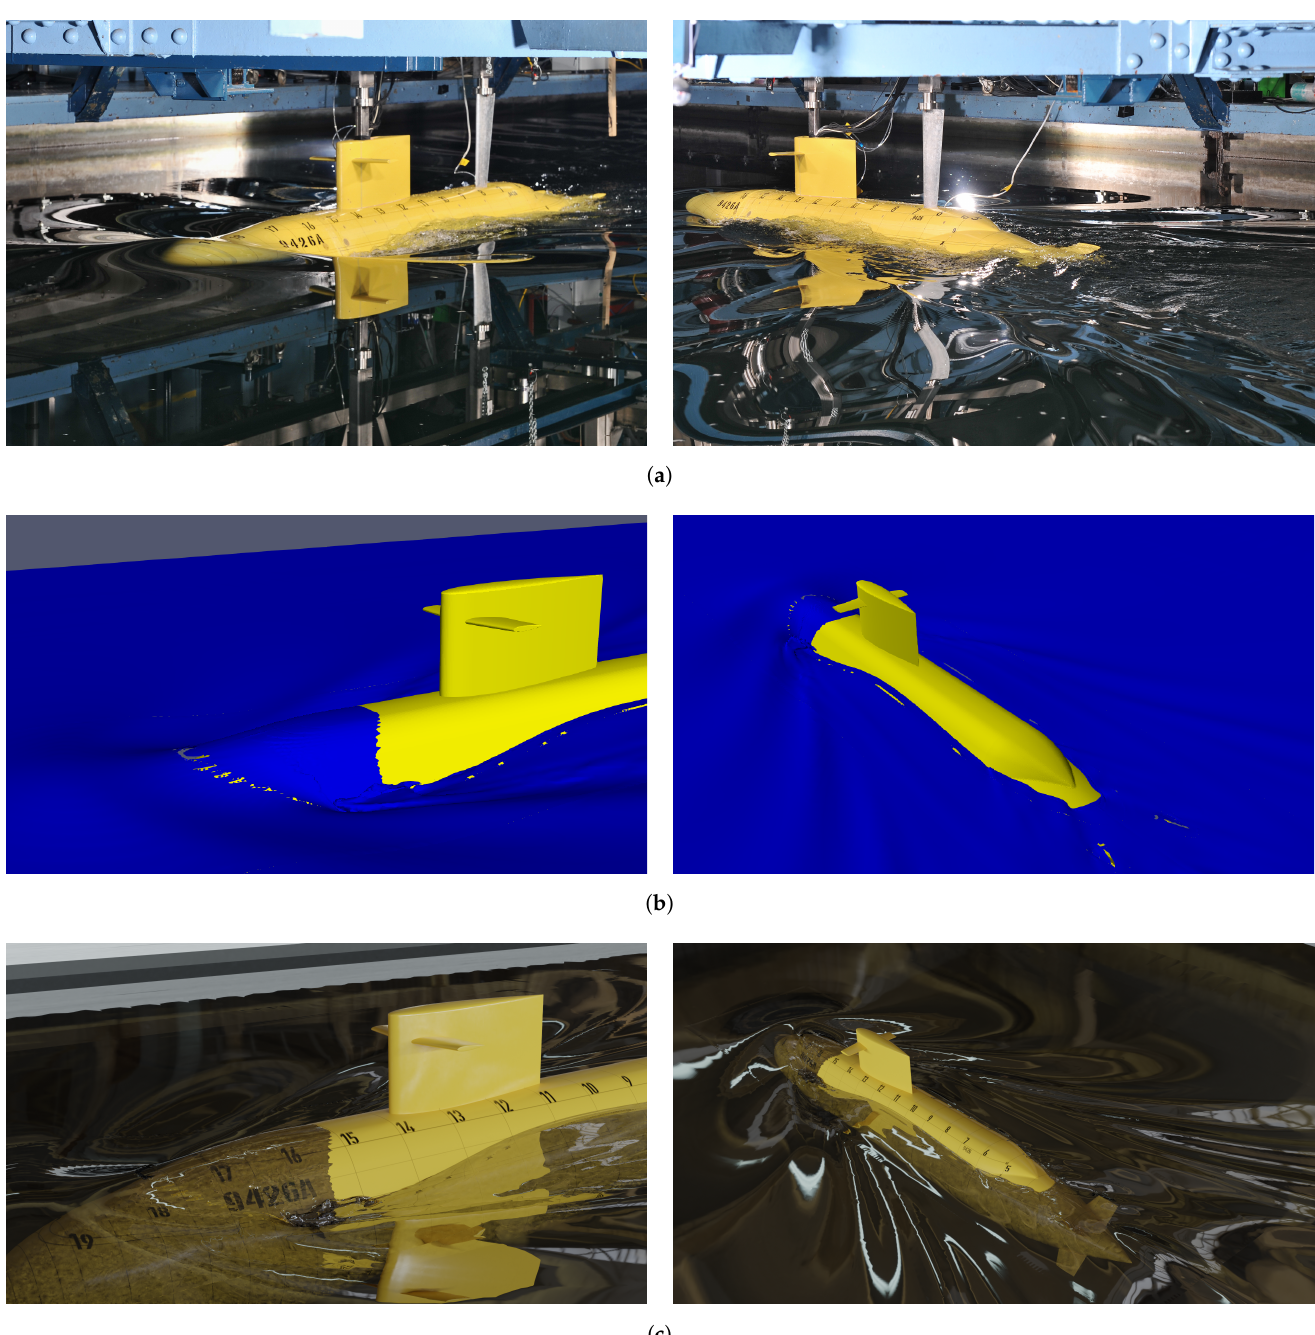
Figure 8. BB1 submarine ( a ) experimental, ( b ) ParaView, rasterisation, and ( c ) Blender, ray tracing, visualisation above the water surface, focused on the bow ( left ) and stern ( right ). Free-surface extracted using an air volume fraction iso-contour of